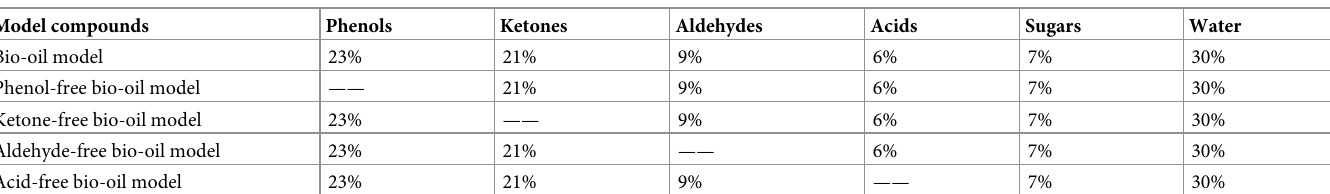
Table 3. Preparation of bio-oil model